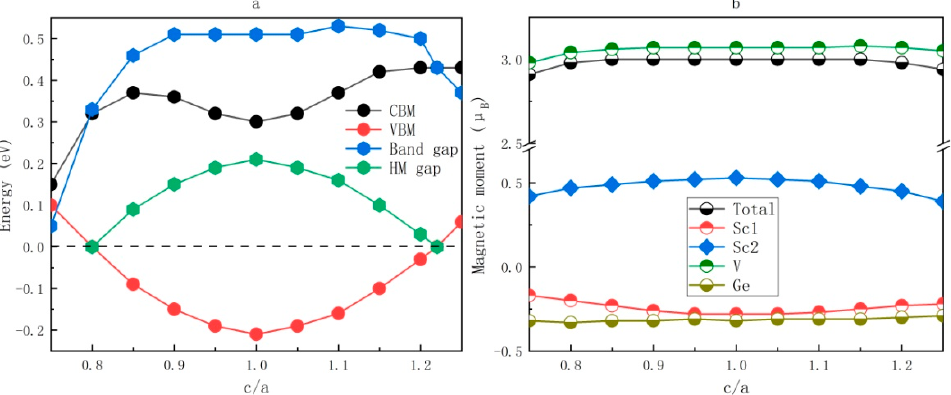
Figure 8. (a) VBM, Bandgaps, and HM gaps of the spin-up channel band as a function of c/a for XA-type Sc 2 VGe, and ( b ) the total and atomic magnetic moments as a function of c/a for XA-type Sc 2 VGe.